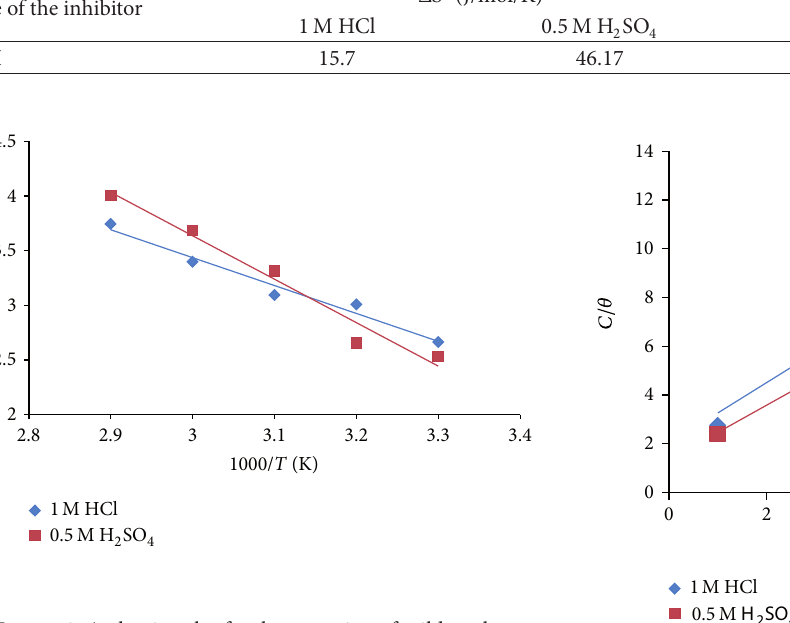
F 2: Arrhenius plot for the corrosion of mild steel.